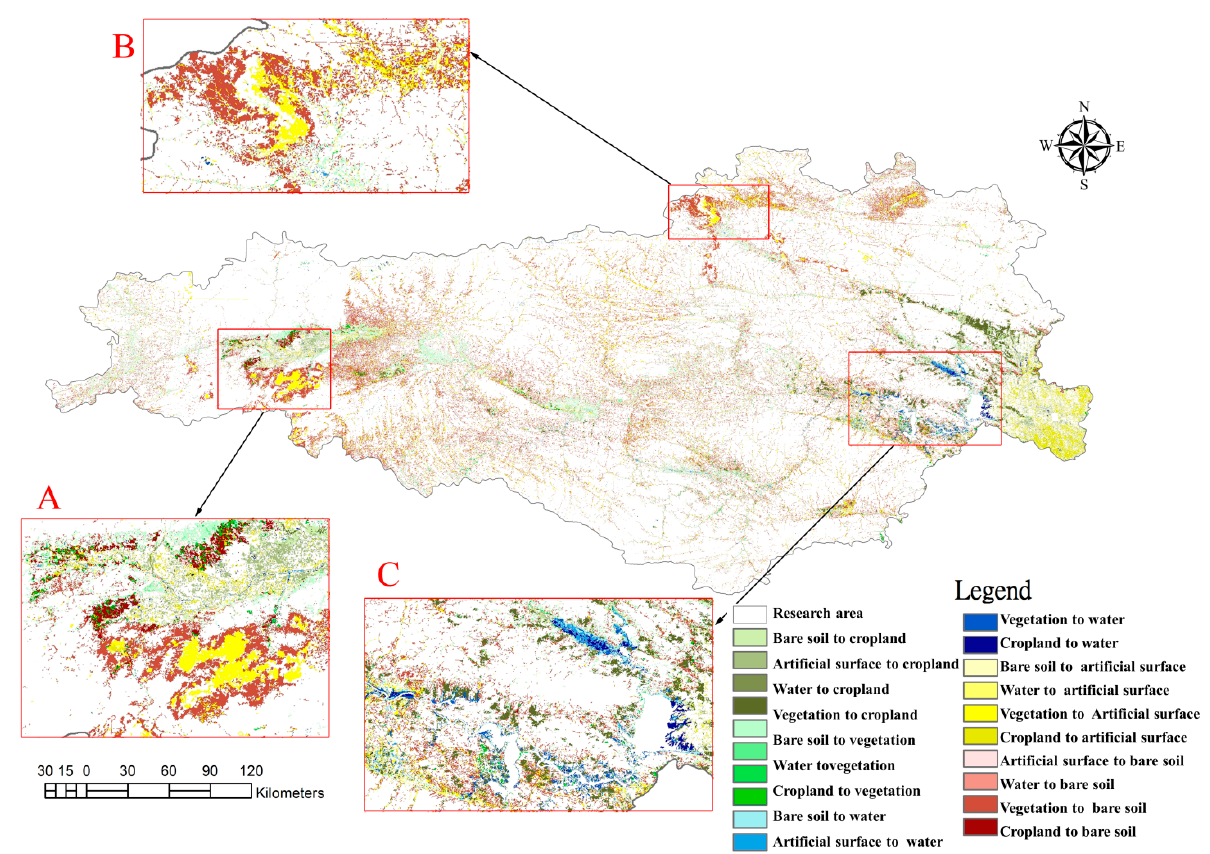
Figure 5. Land use of Danjiangkou water source in 2019.